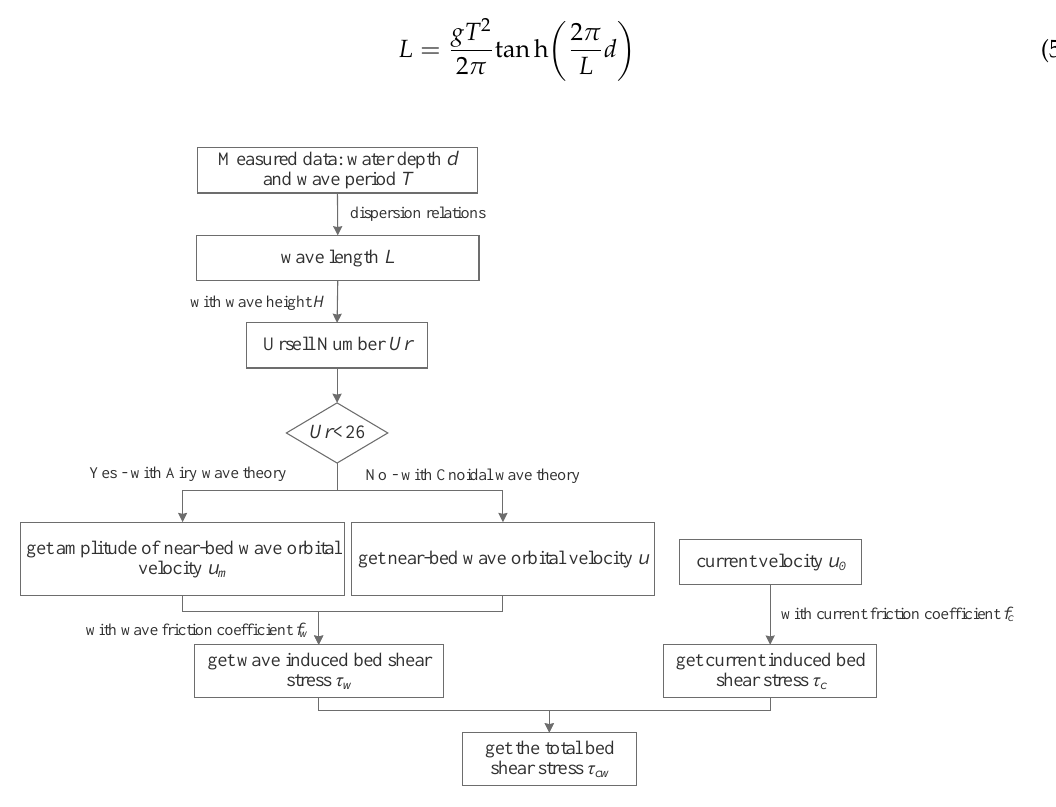
Figure 2. Flow chart to calculate the total bed shear stress.